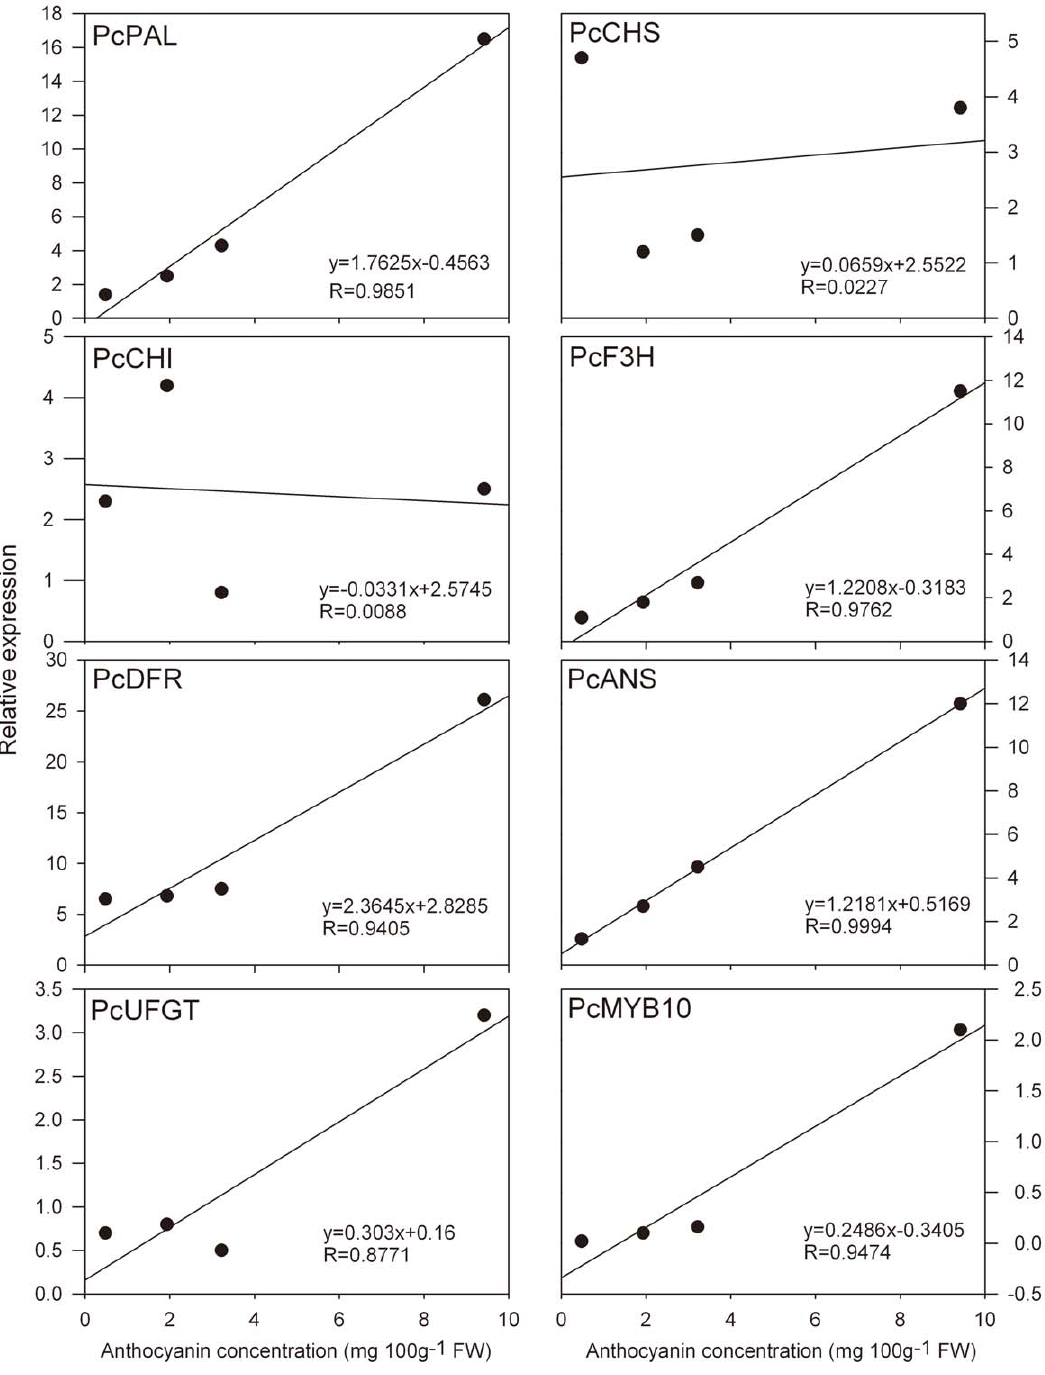
Figure 3. Correlation between anthocyanin concentration and the expression profile of anthocyanin biosynthetic genes in ‘Wujiuxiang’ pears during